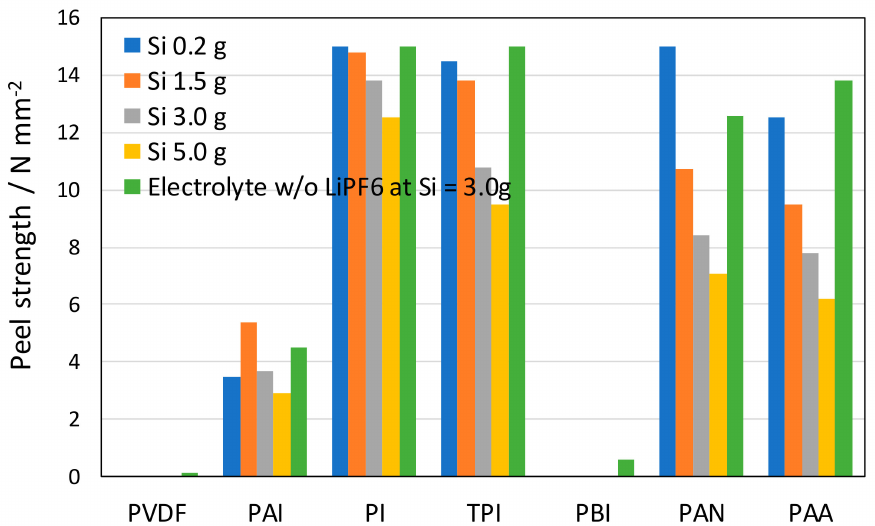
Figure 3. Comparison of peel strength for Si content within electrolyte. Polyvinylidene difluoride, PVDF; polyamide-imide, PAI; polyimide, PI; thermoplastic polyimide, TPI; polybenzimidazole, PBI; polyacrylonitrile, PAN; polyacrylic acid,